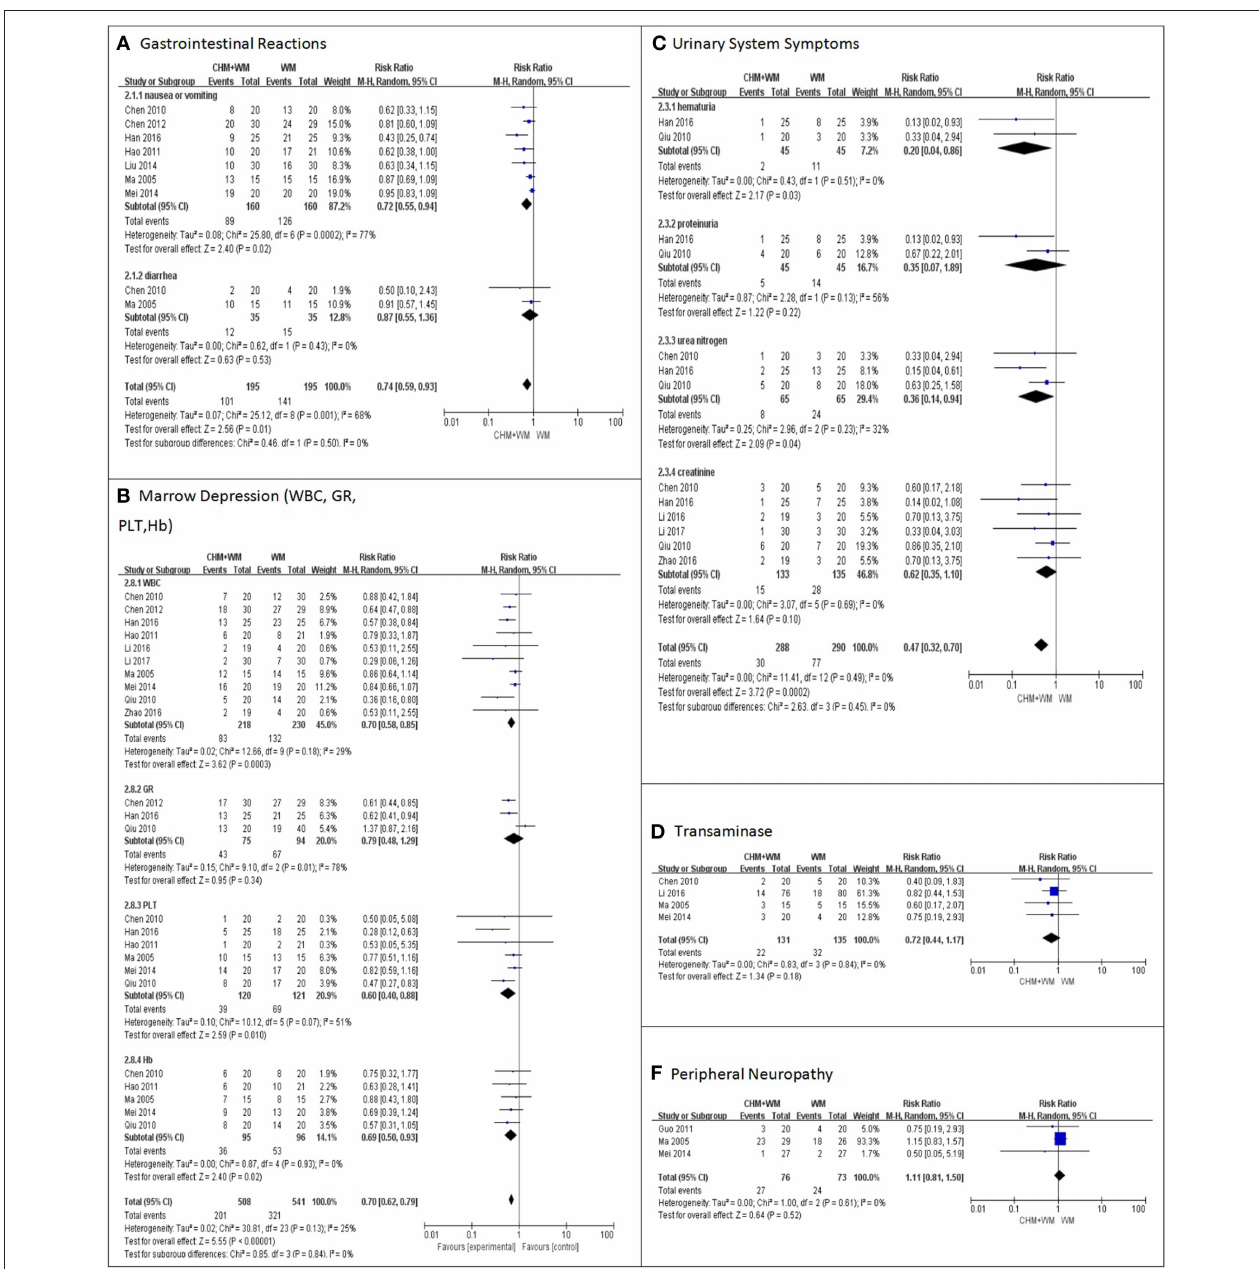
FIGURE 3 | Meta-analysis on safety. (A–F) shown the comparisons and meta-analysis on safety between CHM-WM group and WM group. The I2 statistic described the percentage of total variation across studies that was due to heterogeneity rather than chance. CI indicated the confidence interval. Dichotomous data were presented as pooled Risk Ratio (RR) with 95% confidence intervals (95%